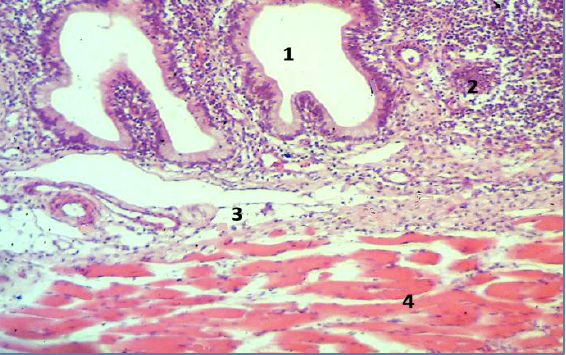
Figure, 10: proctodeum wall (hen turkey) shows: tubular epithelial glands (1) lymphatic nodule (2), tunica submucosa (3) and inner longitudinal striated muscle fibers (4). (H and E)